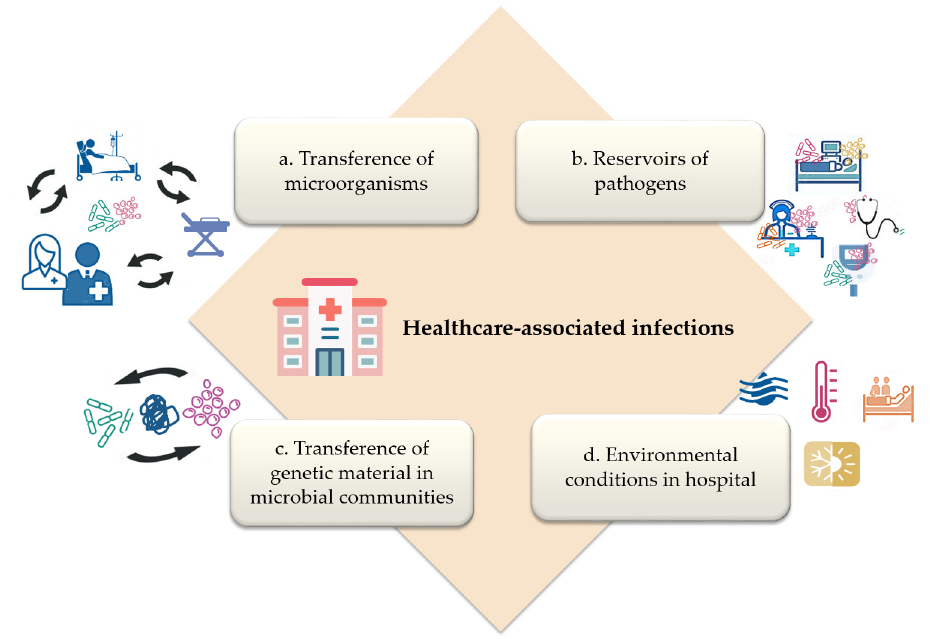
Figure 1. Factors related to healthcare ‐ associated infections development. ( a ) transference of micro ‐ organisms between patients, healthcare workers, and hospital environmental surfaces; ( b ) hospital environmental surfaces, medical devices, healthcare workers, and patients as reservoirs of pathogens; ( c ) transference of genetic material associated with virulence, persistence, and antibiotic resistance in microbial communities; ( d ) environmental conditions, such as temperature, seasonal trend, humidity relative, and occupancy support persistence, diversity, and abundance of microorganisms on environmental surfaces.